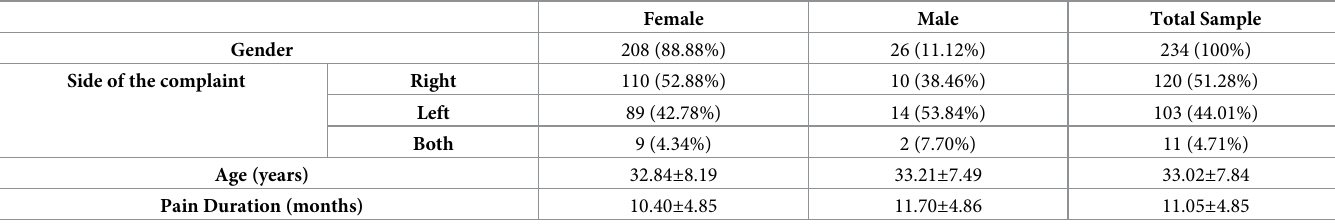
Table 1. Distribution of the frequency, average and standard deviation ( ± SD) of the descriptive